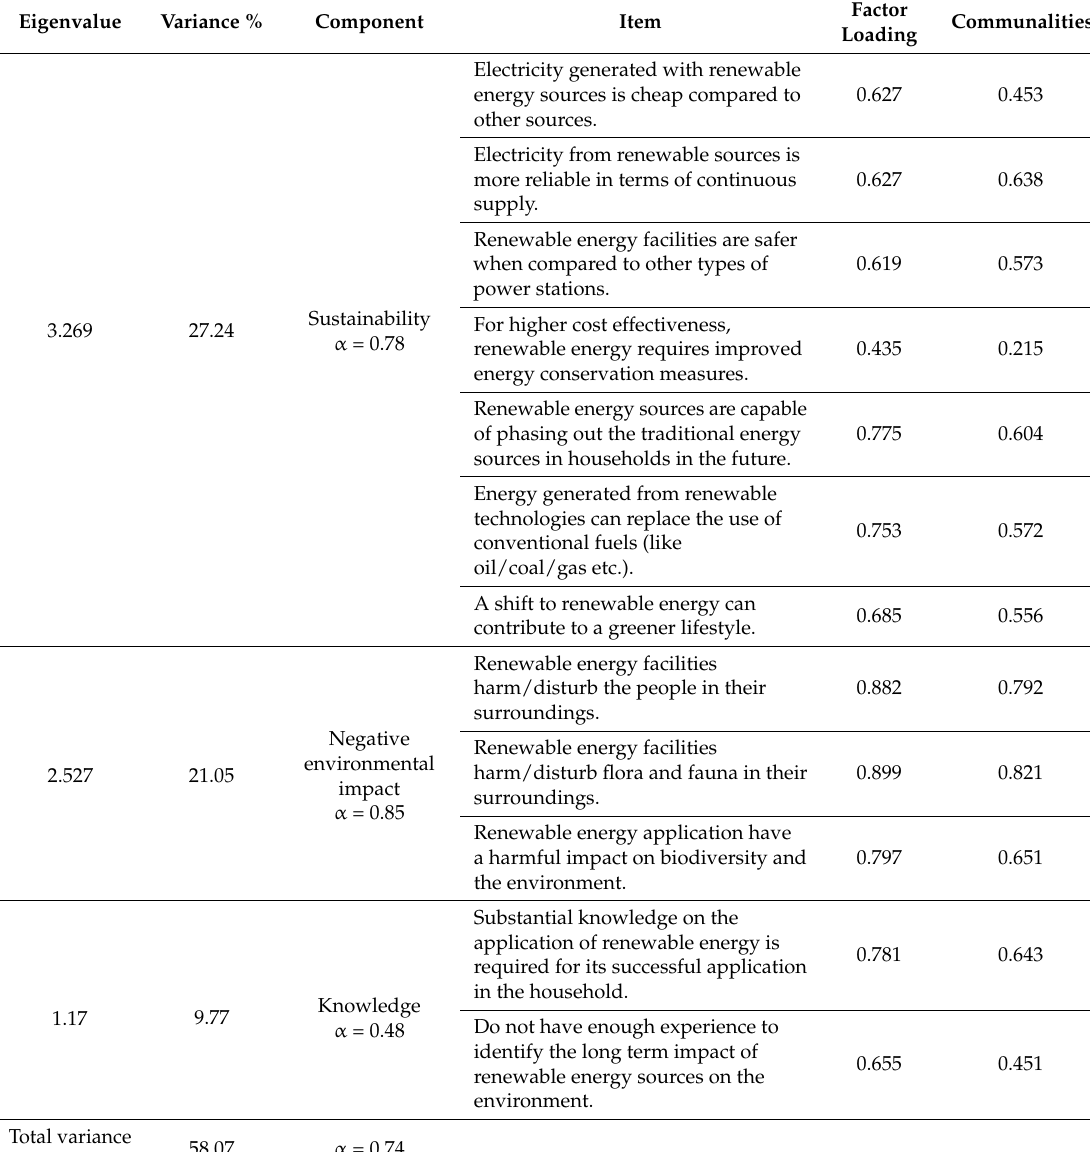
Table 2. PCA regarding the perception regarding renewable sources of